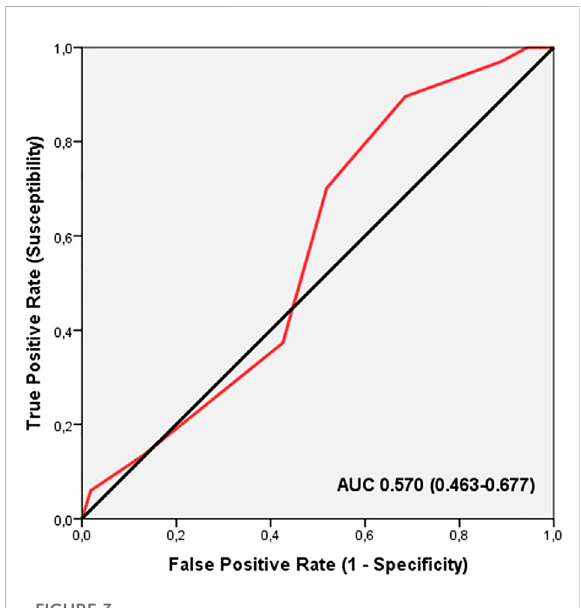
FIGURE 3 Receiver operating characteristic curve (ROC) summarizing theabilityofthetotalgenotypescore(TGS)todistinguishpotential musculoskeletal non-injuredplayers from musculoskeletalinjured players in muscle performance pro fi le, AUC, area under the